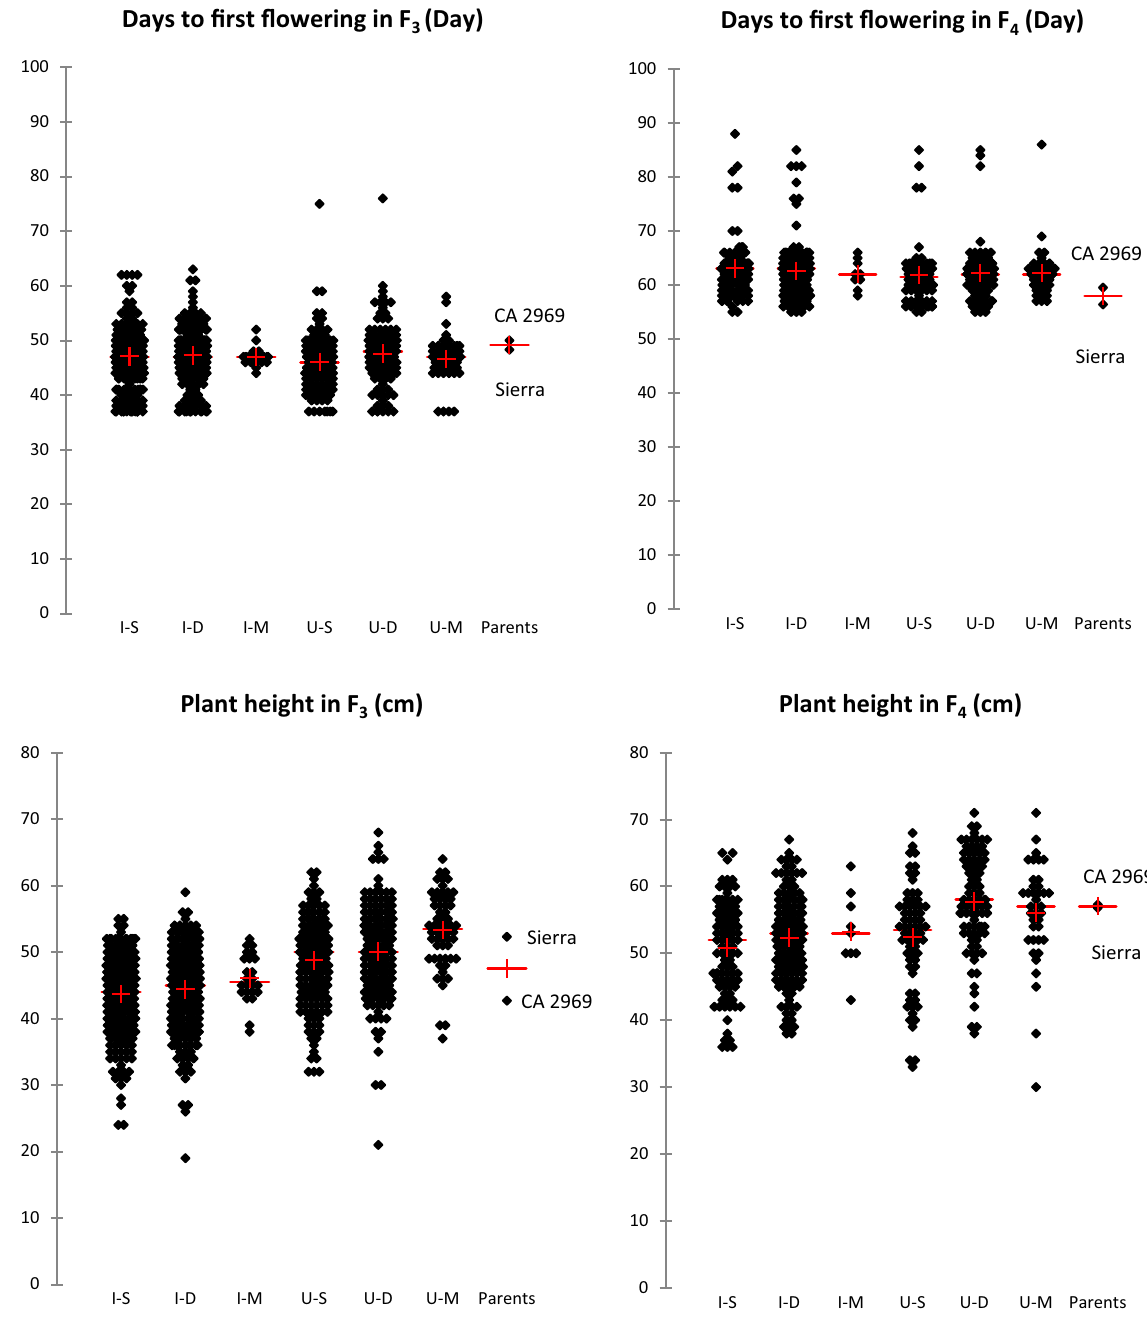
Figure 1. Means (+) of transgressive segregations and superior lines for days to first flowering and plant height in F 3 and F 4 populations derived from intraspecific crosses between Sierra and CA 2969. Each dot represents a progeny. I–S: imparipinnate-leafed and single-podded progeny, I–D: imparipinnate-leafed and double-podded progeny, I–M: imparipinnate-leafed and multi-podded progeny, U–S: unifoliolate-leafed and single-podded progeny, U–D: unifoliolate-leafed and double-podded progeny, U–M: unifoliolate-leafed and multi-podded Plant height and number of main stems per plant of the F 3:4 superior lines varied from 39 to 73 cm and from 2 to 6, respectively (Table 3). Average first pod height was 41.2 cm, while mean canopy width was 50.1 cm. Pods and seeds per plant ranged from 1 to 76 and from 1 to 75, respectively. Seed yield per plant varied from 0.4 to 30.7 g. 100-seed weight ranged from 23.2 to 69, while mean seed yield per plant was 43.8 g. Biological yield in F 3:4 superior lines was determined as 0.5–74.1 g, while harvest index was 3.5–86.5%.